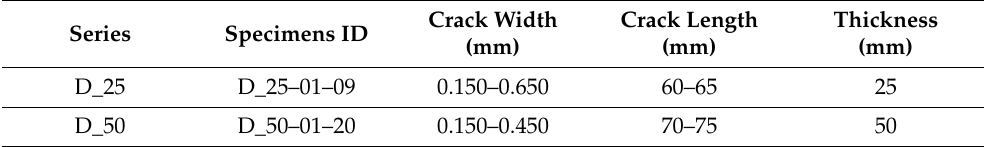
Figure 5. Crack width measurement using a microscope.